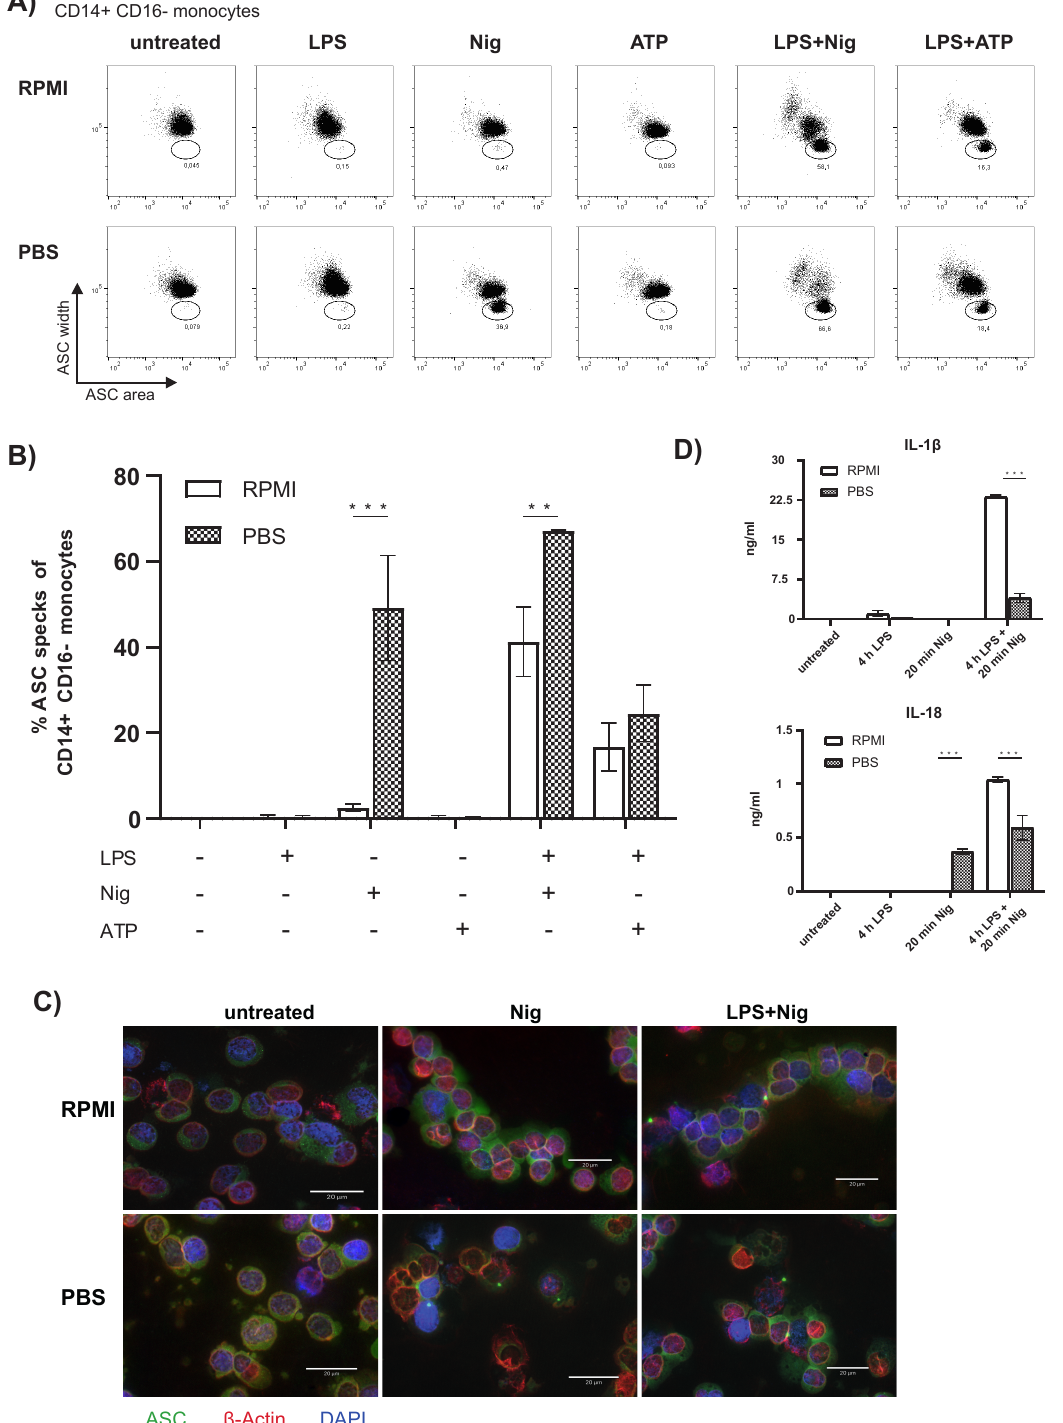
Figure 3. Incubation of PBMCs with Nig in PBS leads to high numbers of ASC speck + monocytes. ( A , B ) ASC speck formation in CD14 ++ CD16 − monocytes after stimulation as indicated or untreated ( A ) Representative dot plots and ( B ) Quantification of data. ( C ) Fluorescence microscopic images of ASC speck formation in untreated or stimulated PBMCs. ASC (green), β -actin + (red) and DAPI (nuclei, blue) (scale bar 20 µ m). ( D ) Cytokine levels in the supernatant of untreated or stimulated PBMCs as indicated. Repeated measure one-way ANOVA for ( B ) and a two-way ANOVA for ( C ), followed by a Bonferroni multiple comparison test was performed. A p -Value ** p < 0.01; *** p < 0.001 was considered significant ( n = 3 measured as triplicates and represented as the mean value from these, from four independent experiments for ( B ) and n = 3 measured in duplicates for ( D ), shown mean ±